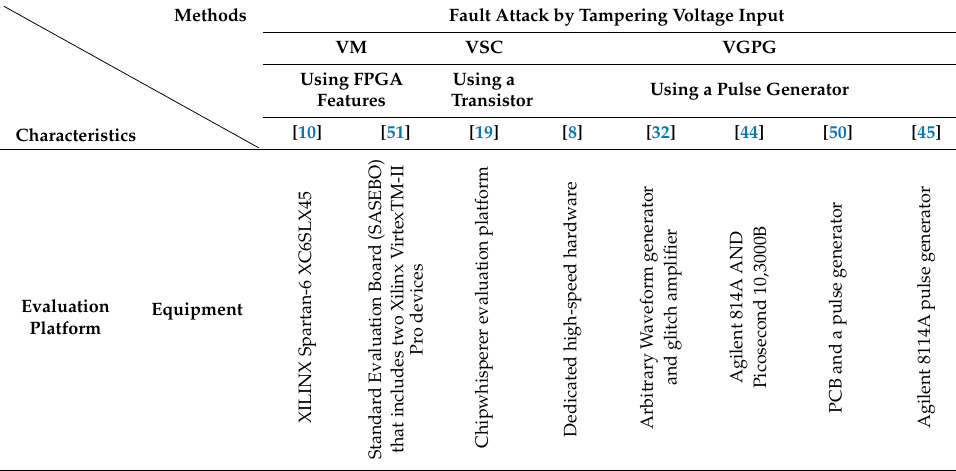
Table 4. Review of previously proposed voltage glitch generators